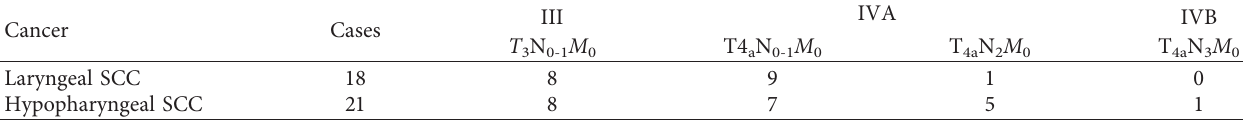
Table 1: Main clinical and pathologic characteristics of laryngeal SCC and hypopharyngeal SCC.